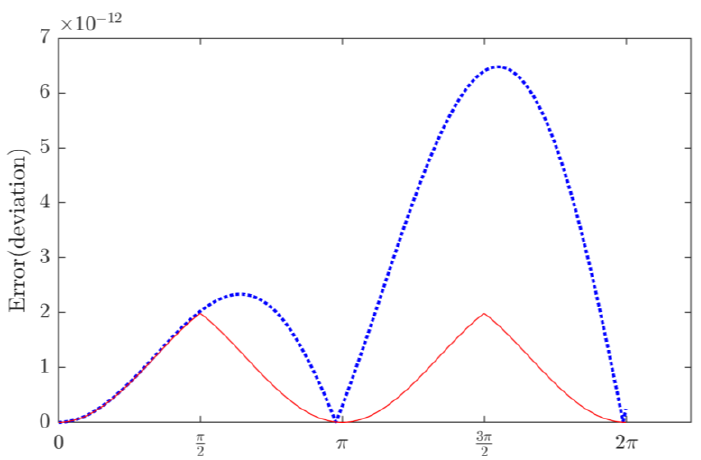
Figure 4. Accuracy comparison of the RT algorithms using and without using the quadrant transformation, represented by a solid line and a dashed line, respectively.